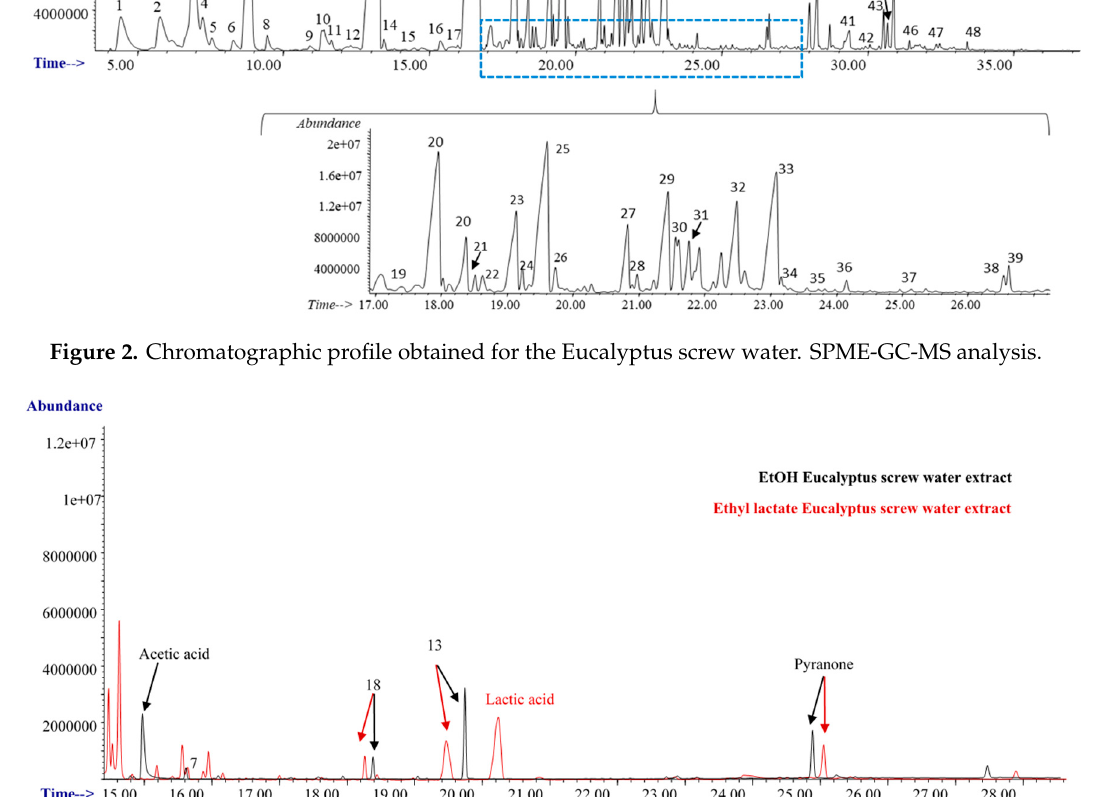
Figure 3. Chromatographic profile for the ethanolic (black) and ethyl lactate (red) extracts derived from the screw water. GC-MS analysis. The differences in the retention times are due to the different organic solvents employed.